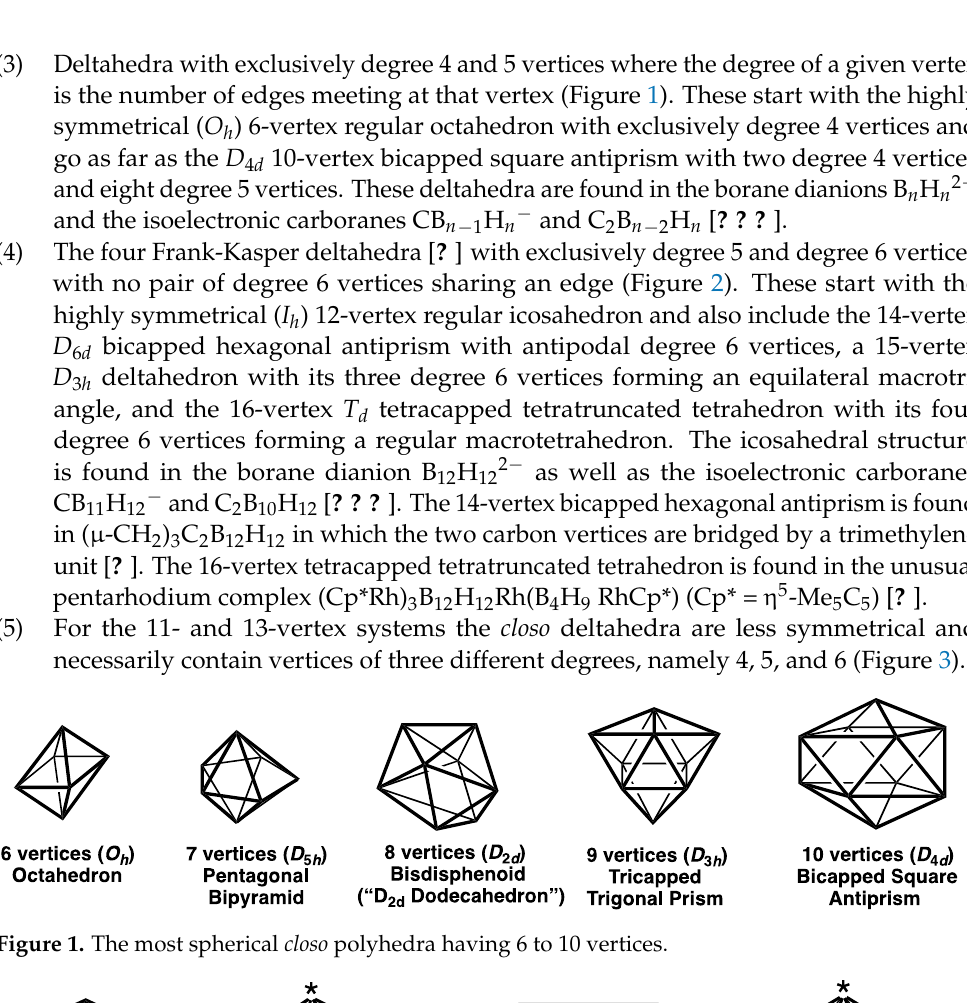
Figure 1. The most spherical closo polyhedra having 6 to 10 vertices.